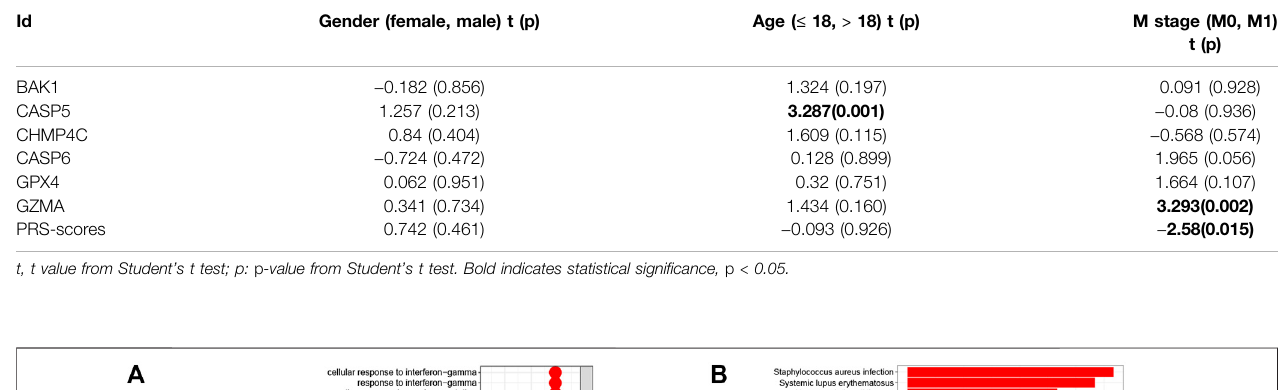
scores ( Figure 5D ), with AUC (cid:1) 0.673, 0.657, and 0.585 for 1, 3, and 5 years survival, respectively ( Figure 5E ).